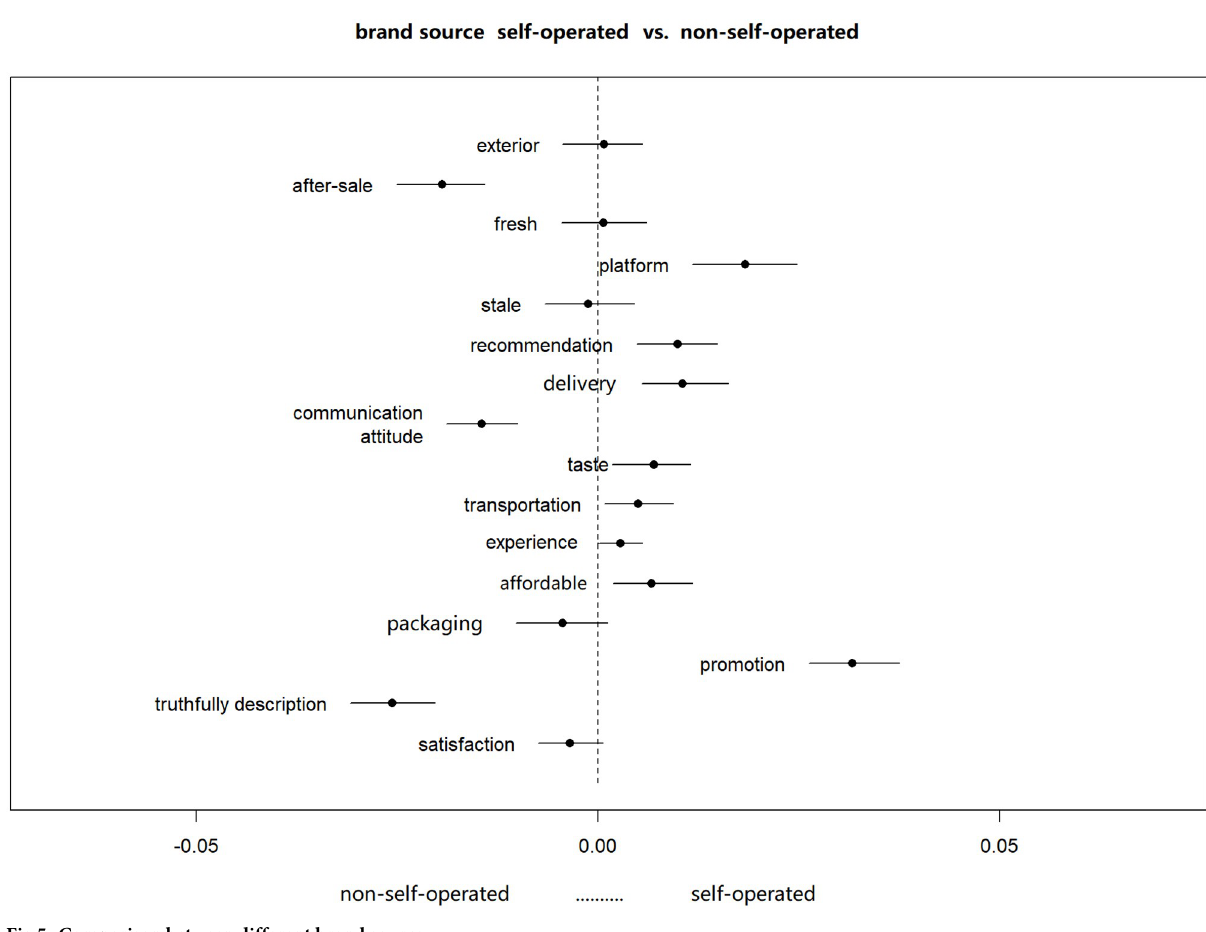
Fig 5. Comparison between different brand